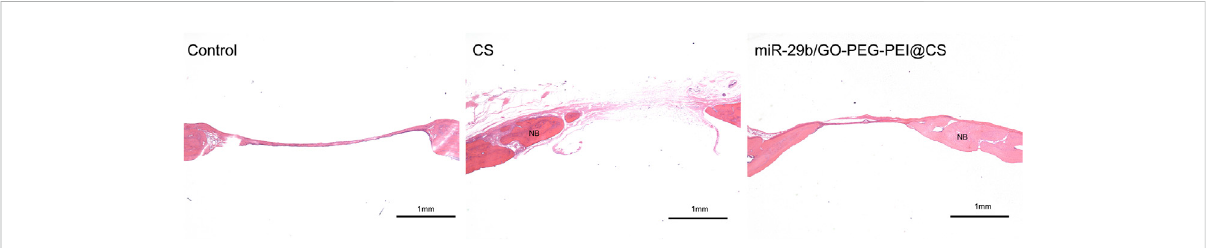
FIGURE 11 Typical histological sections of rats skull defects in control, CS and miR-29b/GO-PEG-PEI@CS groups. Samples were stained with H&E. NB indicates new bone. Scale bar is 1